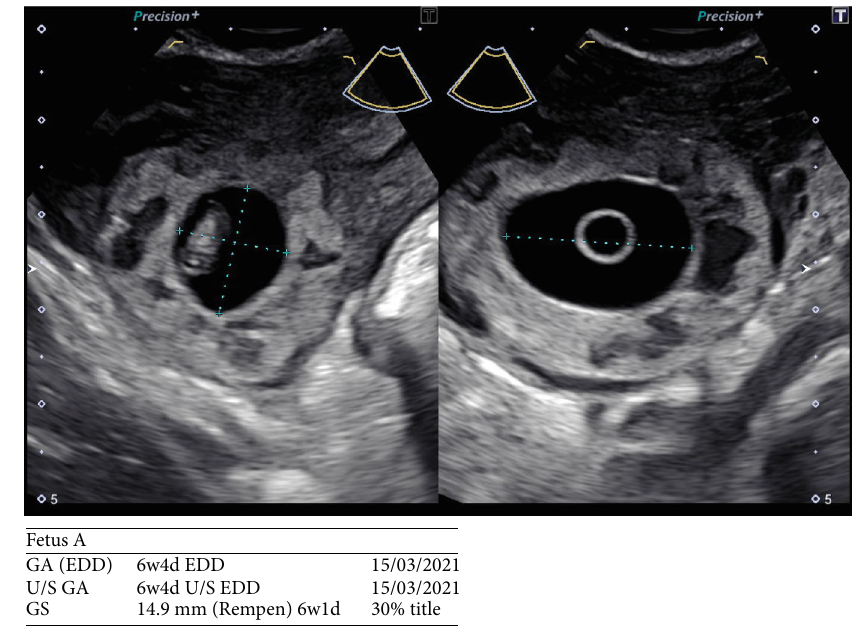
Figure 2: Ultrasound image of the ectopic gestational sac.